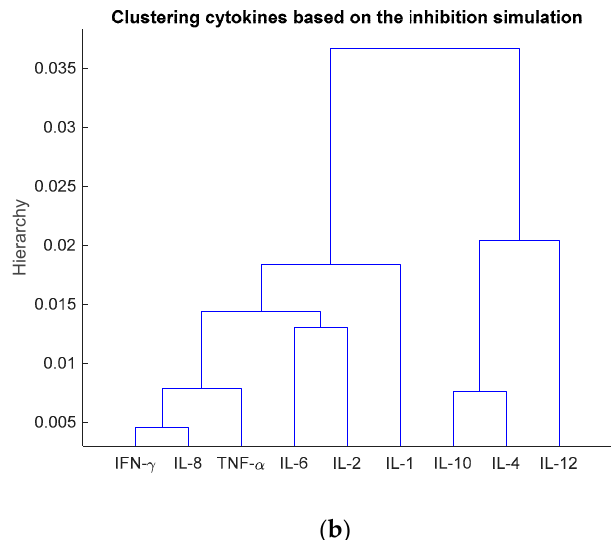
Figure 7. Project the nine cytokines onto the Principal Component 1 and 2 (PC1–PC2) space on the basis of the CRS grade of their inhibition ( a ), and cluster them based upon their projection on to the PC1–PC2 space ( b ).